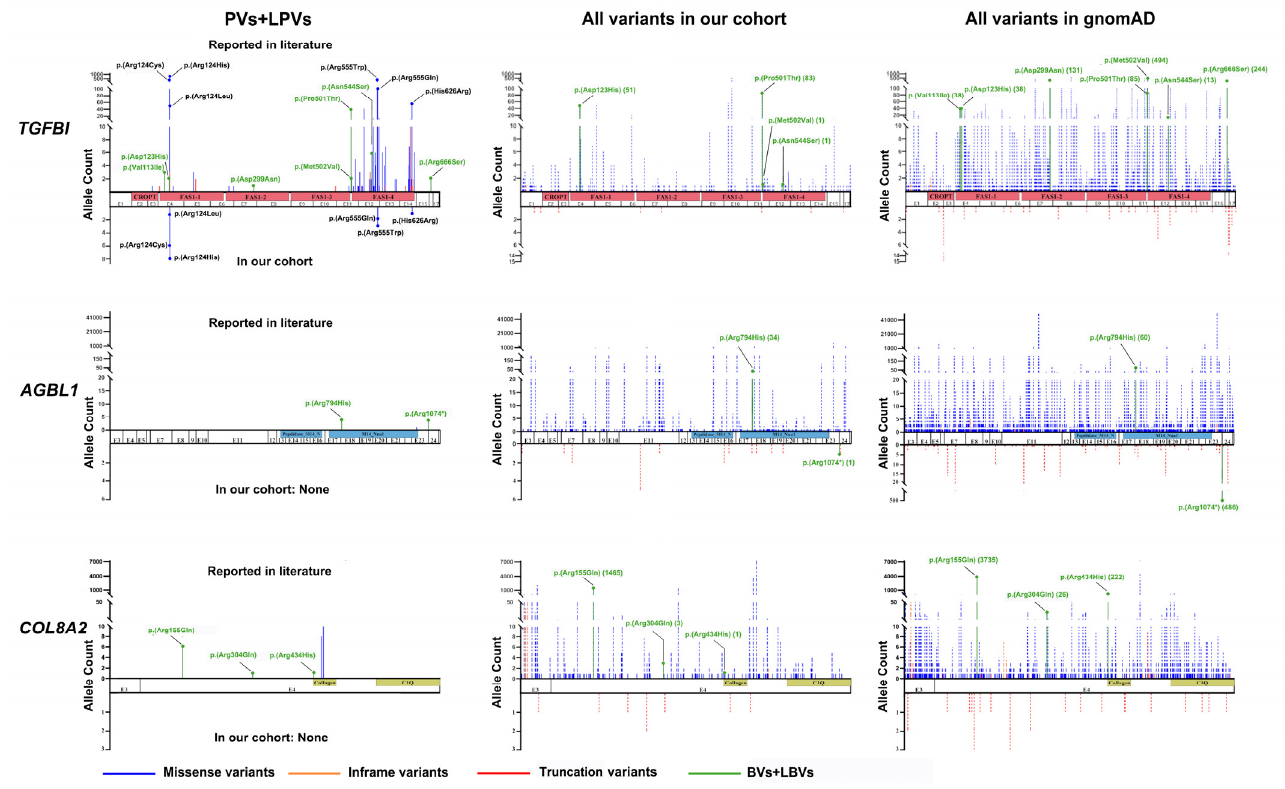
Figure 5. Distribution and frequency of pathogenic variants (PVs) and likely pathogenic variants (LPVs) in TGFBI , AGBL1 , and COL8A2 in our in-house database and previously reported literature, and variants in our cohort and gnomAD. The green font indicates benign variants (BVs) and likely benign variants (LBVs), and their allele number in our cohort or gnomAD is noted in parentheses. The black font indicates pathogenic or likely pathogenic variants that are hot spots in TGFBI . The dotted line indicates variants in population without phenotype of CDs. The solid line indicates variants in patients with CDs. Truncation variants include splicing variants, frameshift variants, and nonsense variants.